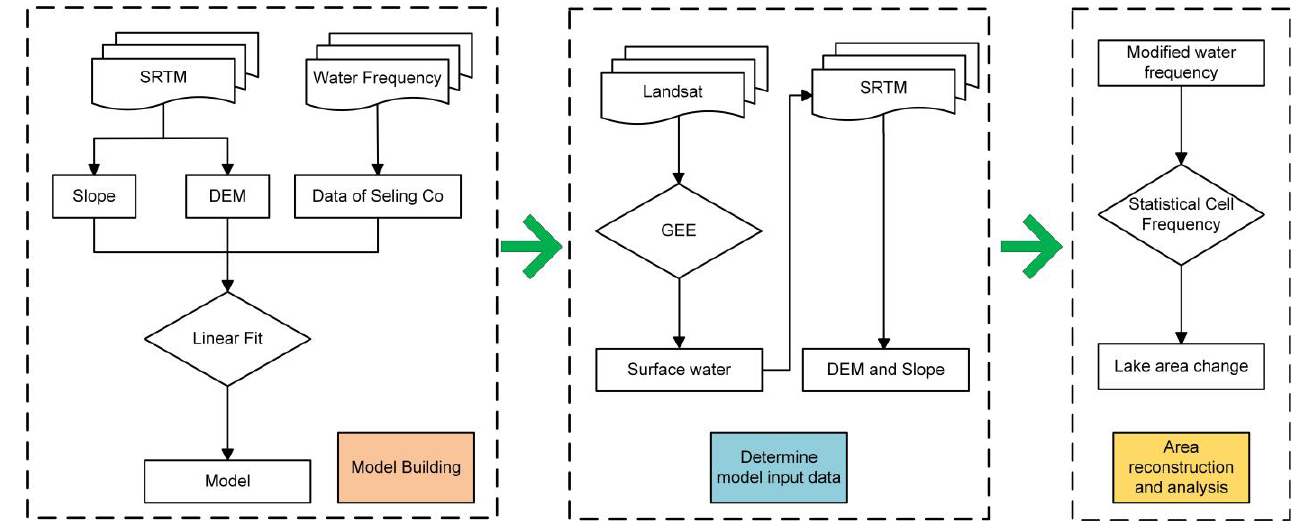
Figure 2. Workflow for reconstructing the area of Seling Co Lake.